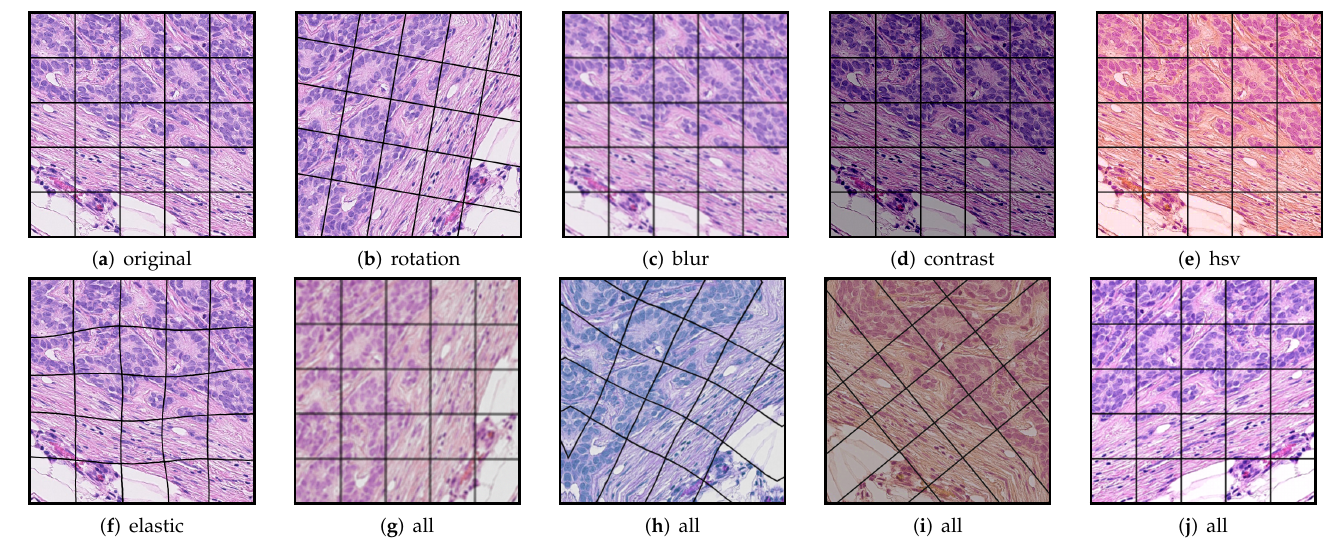
Figure 8. Augmentations used during training applied to a single patch.